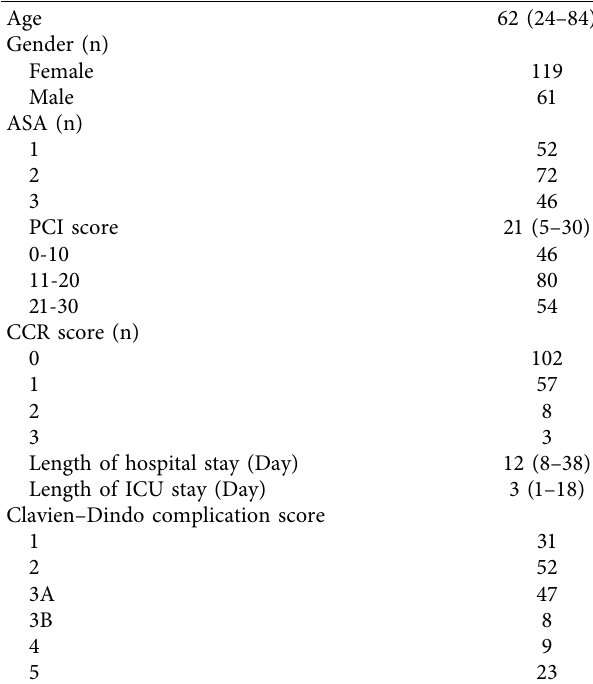
Table 2: Patients characteristics. Table 3: Surgical procedures.